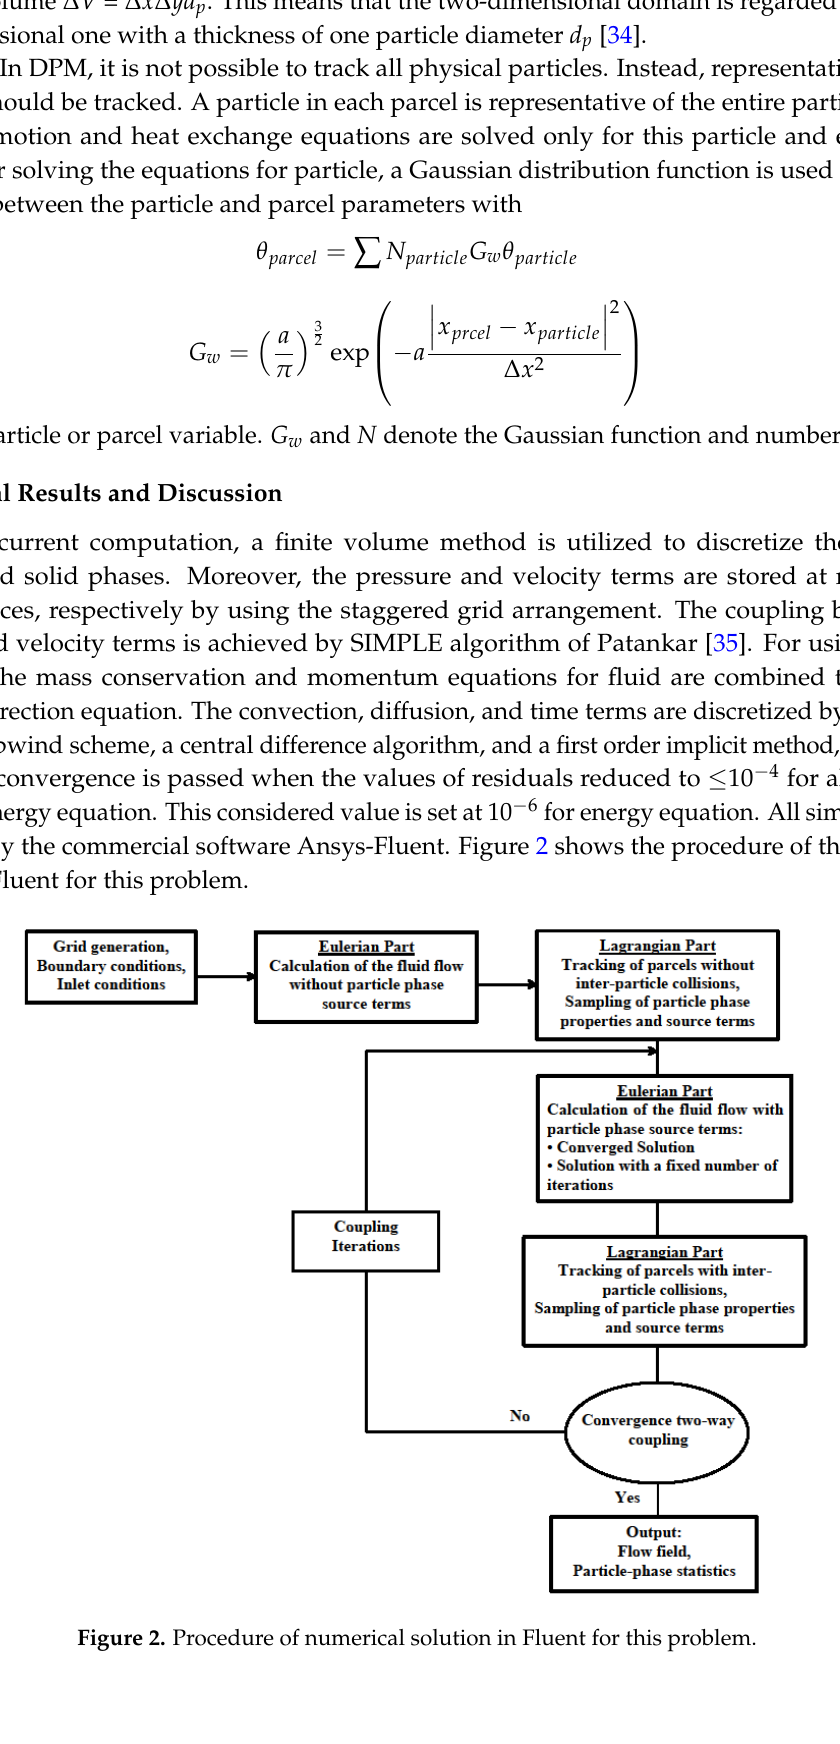
( b ) Figure 3. Mesh distribution ( a ) whole domain ( b ) near the obstacles.